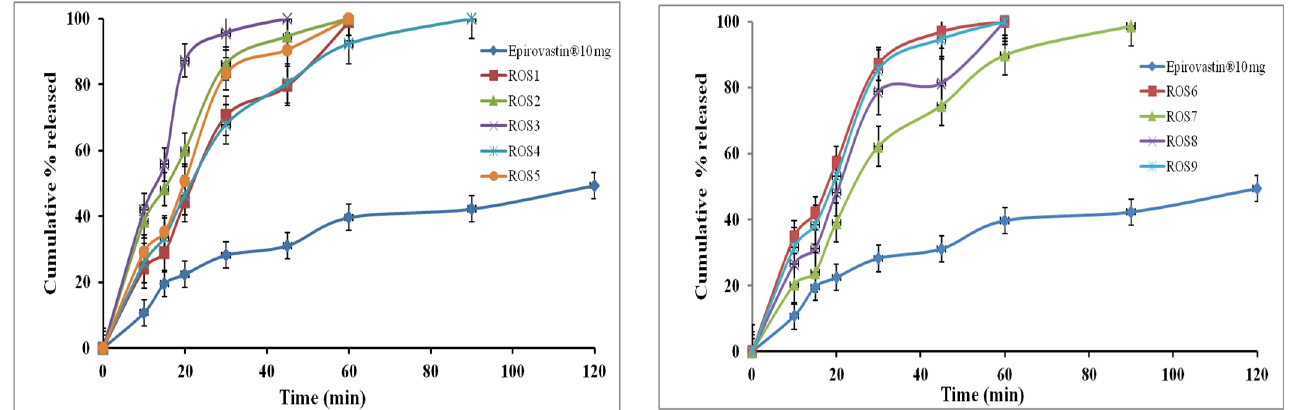
Figure 6. In vitro release profiles of ROS from the commercial and prepared mono tablets (mean ± SD, n = 3).